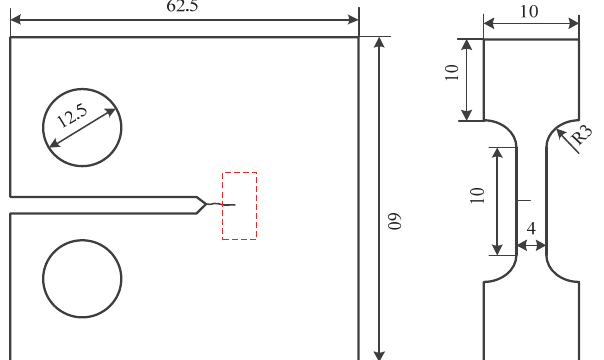
Figure 1: Shape and dimensions of standard CT specimen and the machined small size tensile specimen In-situ fatigue